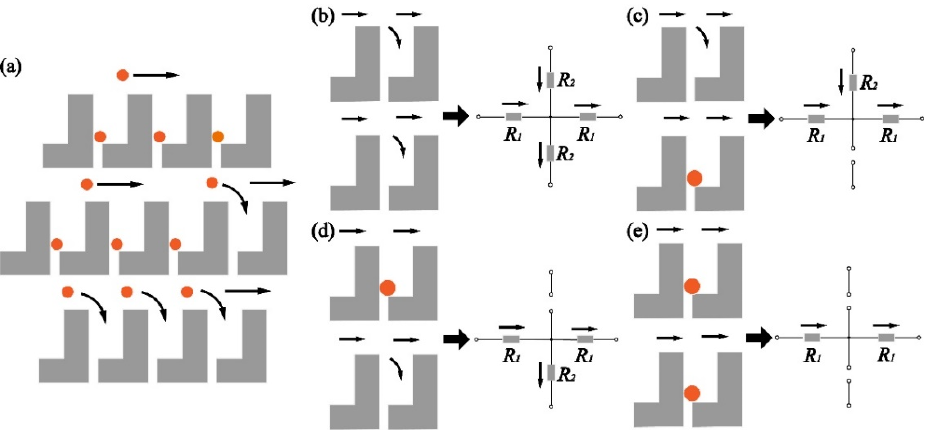
Figure 4. ( a ) Operation principle of the cell trapping in the dentate channel. ( b – e ) Equivalent cir- cuits of the microfluidic pattern.